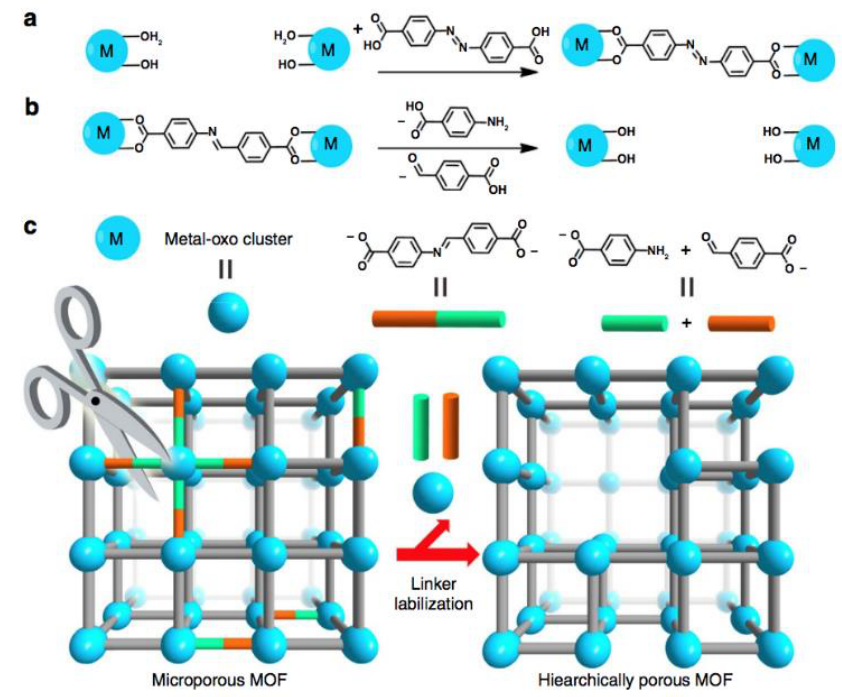
Figure 6. ( a ) Hierarchical PCN-160 linker installation, ( b ) liker labilisation, ( c ) hierarchically porous MOF obtained after linker labilisation [92] Adapted from ref. [94] with per- mission.